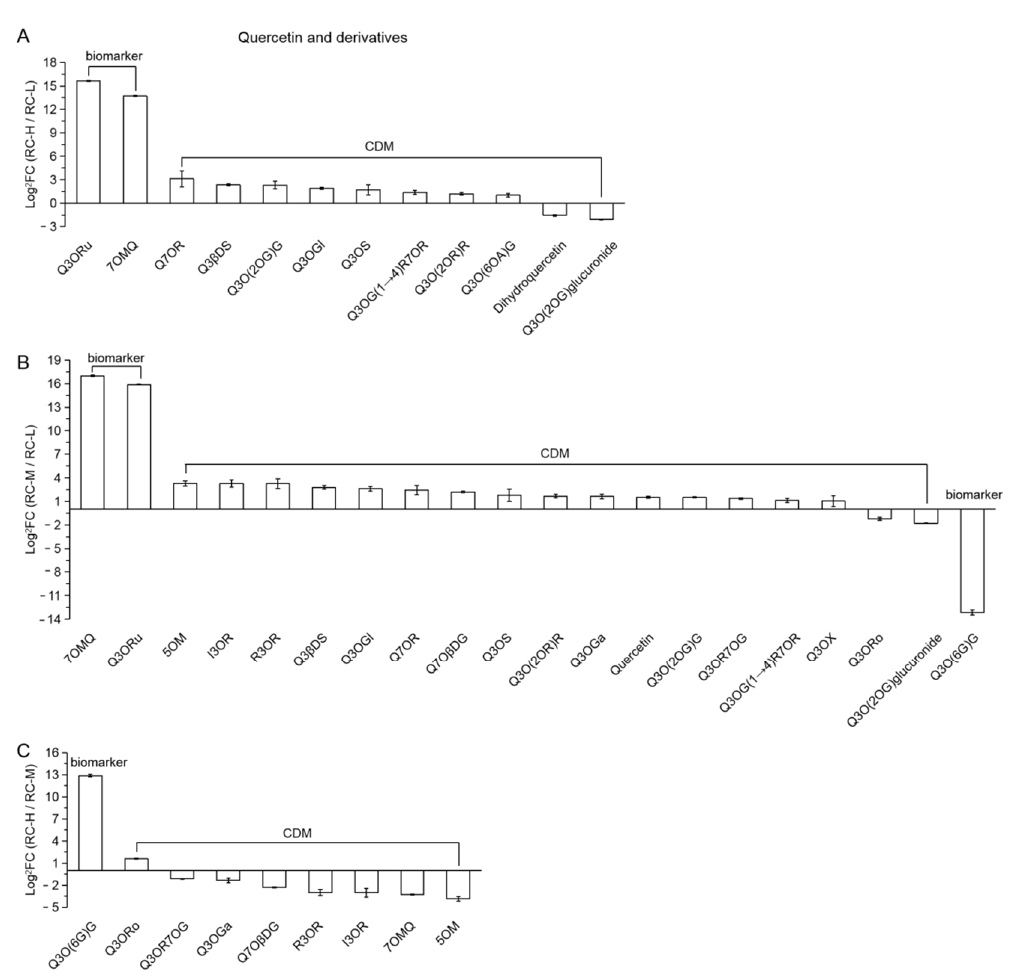
Figure 7. Comparison of differential metabolites of quercetin and its derivatives between RC-L, RC-M and RC-H. These were 2 biomarkers and 10 common differential metabolites (CDMs) for RC-H vs. RC-L ( A ), 3 biomarkers and 17 CDMs for RC-M vs. RC-L ( B ), and 1 biomarker and 8 CDMs for RC-H vs. RC-M ( C ), respectively. Upregulation denotes that the content of a metabolite in RC increased with elevation between two altitudes, and the opposite for downregulation. The Y-axis is shown as Log 2 FC values for the convenience of visual presentation (Note: The up-amplitude in the text refers to the FC value). The X-axis denotes metabolite names.